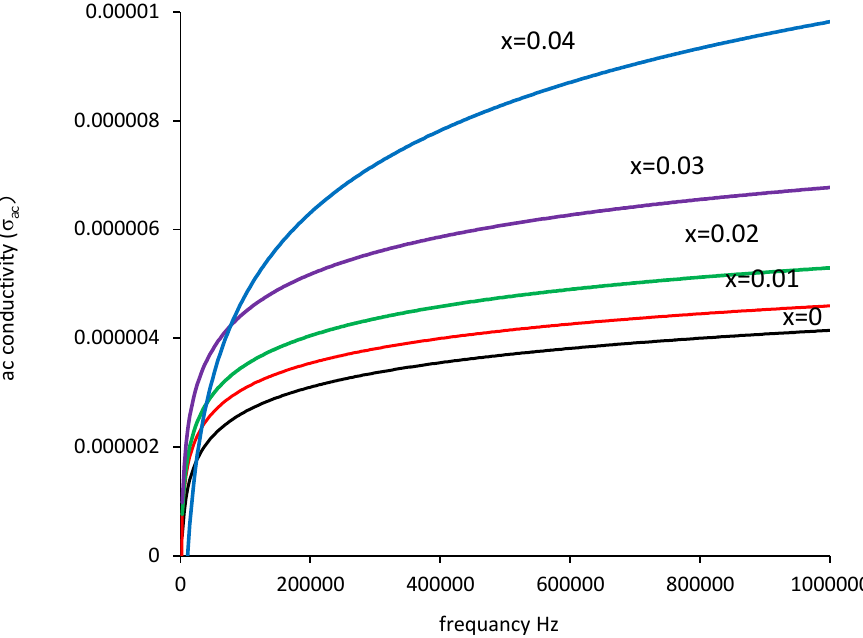
Fig. 8: a.c. conductivity as a function of frequency for Ni